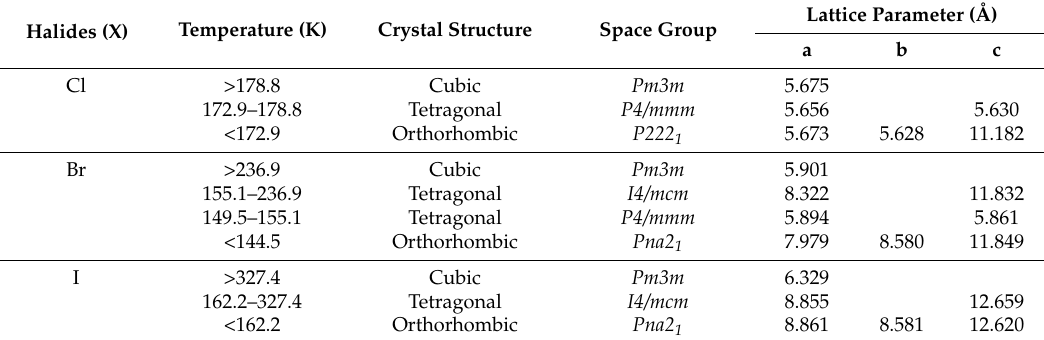
Table 1. Structural data for various methylammonium lead trihalides